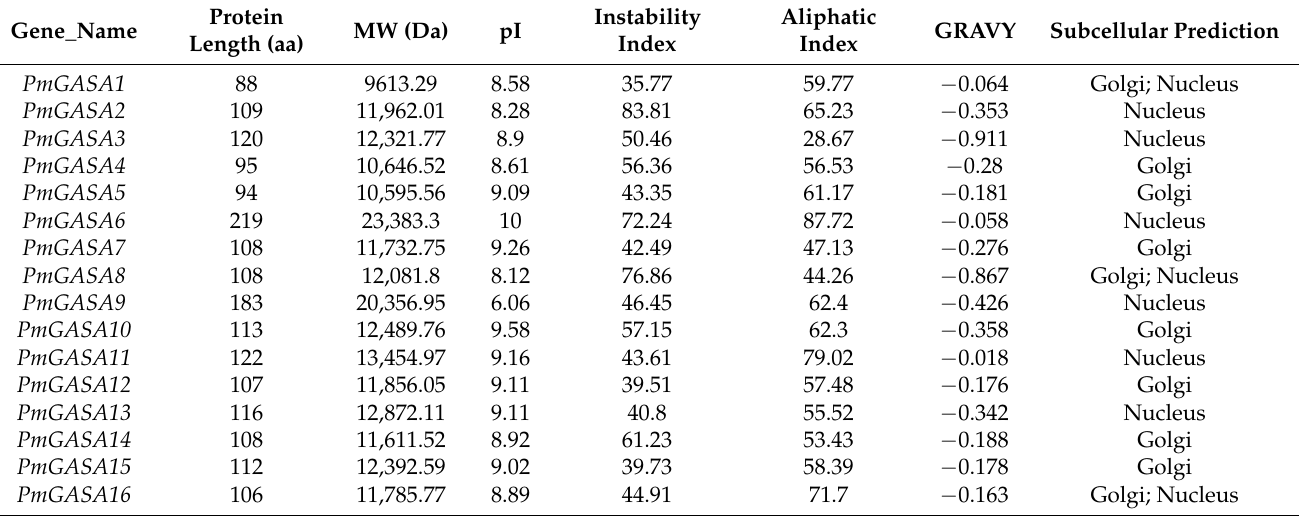
Table 2. Protein physiochemical analysis of GASA family genes identified in P. mume